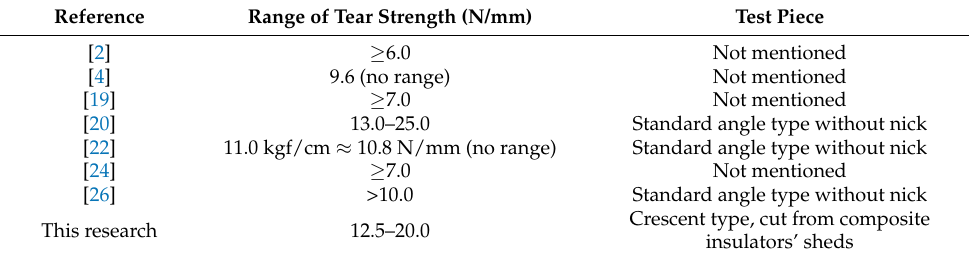
Table 5. Comparative study and contribution to the range of tear strength on new (unused) HTV silicone rubber with ATH filler used as composite insulators’ housing material and the corresponding types of test pieces used.